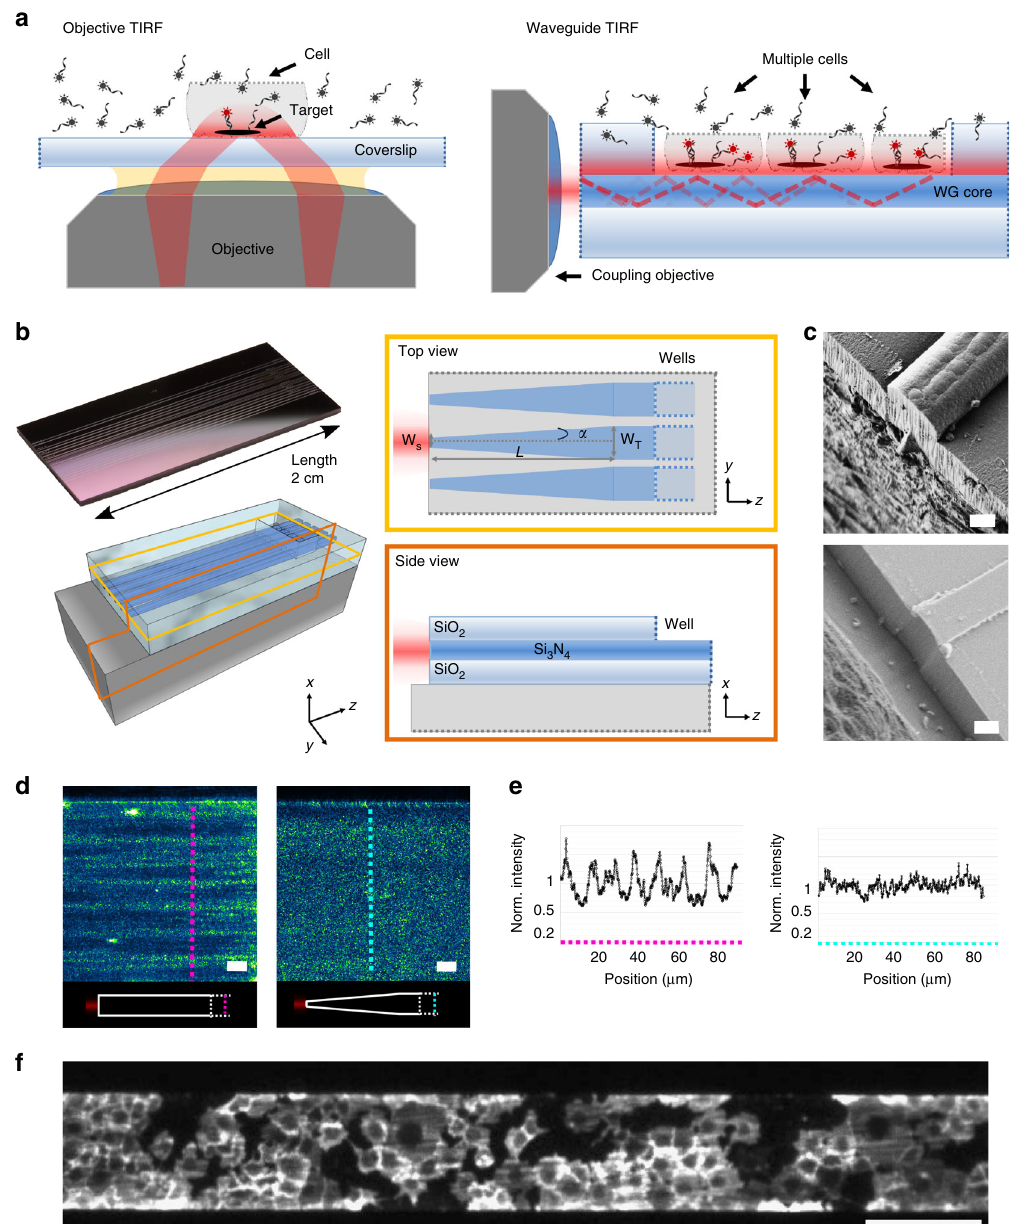
Fig. 1 Optimized waveguide design enables a uniform and large TIRF illumination. a Classical objective TIRF and waveguide TIRF approaches. With objective TIRF, the illumination (red) fi eld size is limited by the objective lens size and magni fi cation and by a roll-off in intensity away from the central axis. In waveguide TIRF, the light (red) undergoes total internal re fl ection at the interface between the core and the aqueous solution, producing an optical sectioning illumination over the entire waveguide surface (up to 2000 μ m in our chips). b The chip design includes an inverted nanotaper with a 150